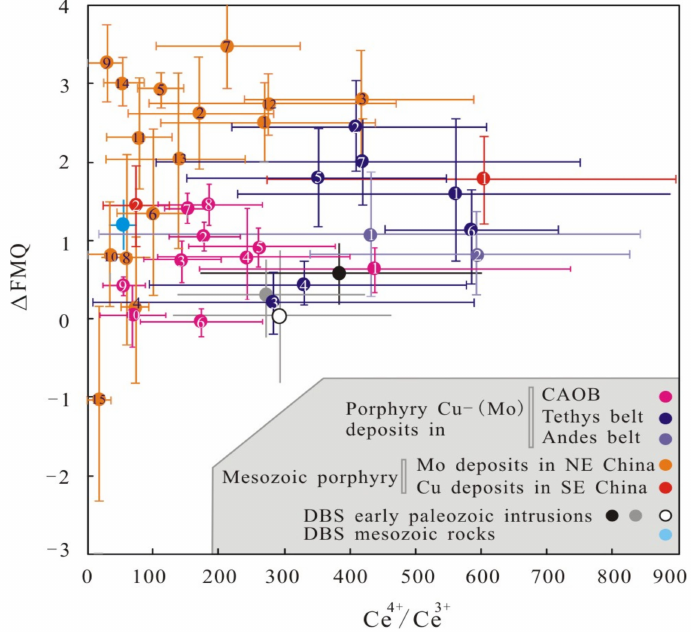
Figure 12. Plots of ∆ FMQ versus Ce 4+ /Ce 3+ for intrusions host to the porphyry Cu-Mo deposits in well-known metallogenic belts. Note: (1) solid circles with numbers refer to porphyry Cu-Mo deposits, which are the same as listed in Table S2; (2). ∆ FMQ values present in this figure are calculated by the method of Loucks et al.